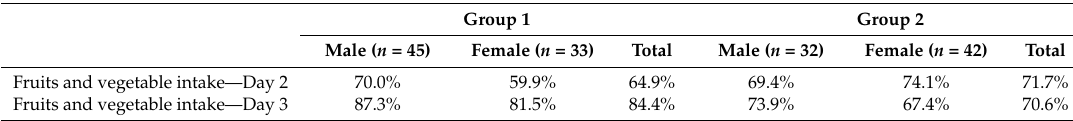
Table 5. The contribution of the University Restaurant to the daily intake of fruits and vegetables by sex and group of students.